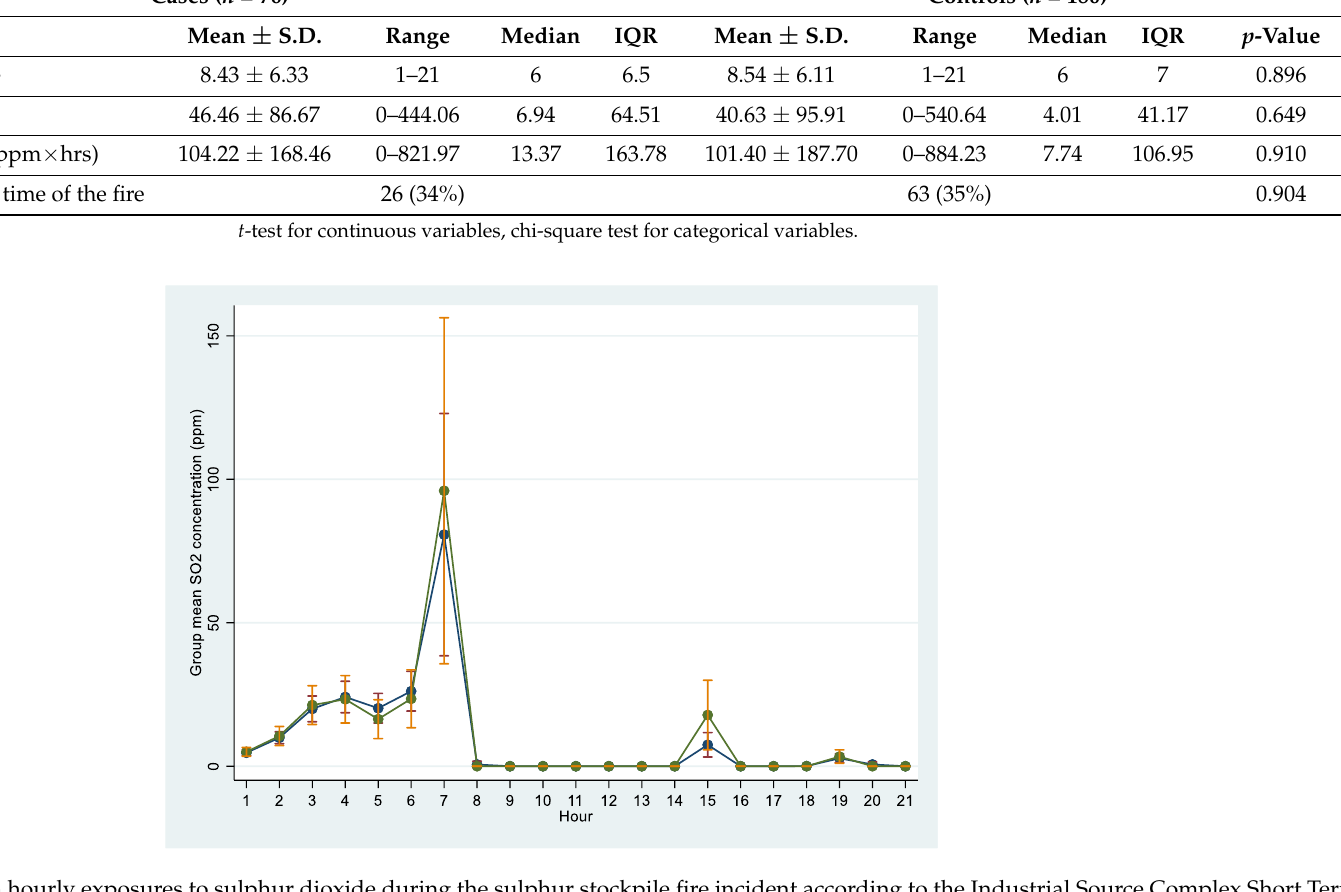
Figure 1. Estimated mean hourly exposures to sulphur dioxide during the sulphur stockpile fire incident according to the Industrial Source Complex Short Term Model (ISCSTM). Legend: green dotted line = cases, blue dotted line = controls